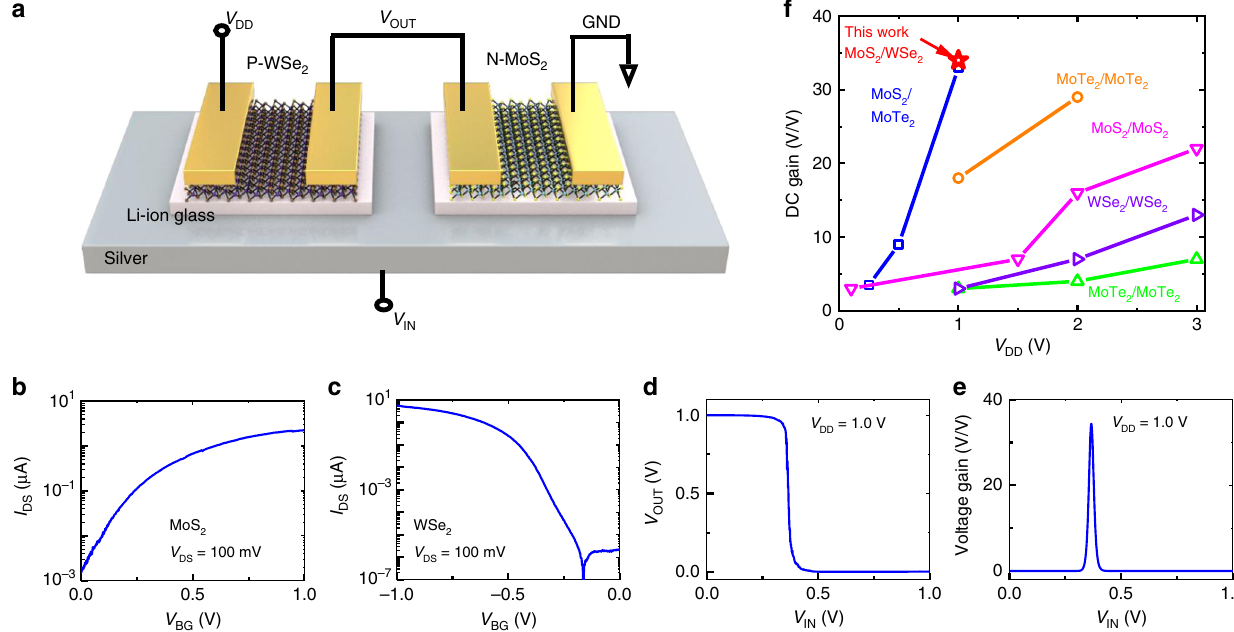
Fig. 4 CMOS inverter based on n-type MoS 2 and p-type WSe 2 FETs. a Schematic of a CMOS inverter with the drain of p-WSe 2 FET connected to the drain of n-MoS 2 FET. Transfer characteristics of b n-type MoS 2 FET. V TH is ~0.25 V. c p-type WSe 2 FET. V TH is ~ − 0.50 V. d Output vs input voltage characteristics of the inverter. The mid-point voltage V M is 0.38 V. Noise margin high (NM H ) and low (NM L ) as calculated from the graph are 0.56 V and 0.27 V, respectively. e Voltage gain vs. input voltage curve with a maximum gain of ~34 at V IN = 0.37 V. f DC gain vs. supply voltage ( V DD ) of our n-MoS 2 / p-WSe 2 CMOS inverter (red) along with other CMOS inverters from the literature such as n-MoS 2 /p-MoTe 2 (blue) 60 , n-MoTe 2 / p-MoTe 2 (orange) 61 , n-MoS 2 /p-MoS 2 (magenta) 62 , n-WSe 2 / p-WSe 2 (violet) 63 , and n-MoTe 2 / p-MoTe 2 (green) 64